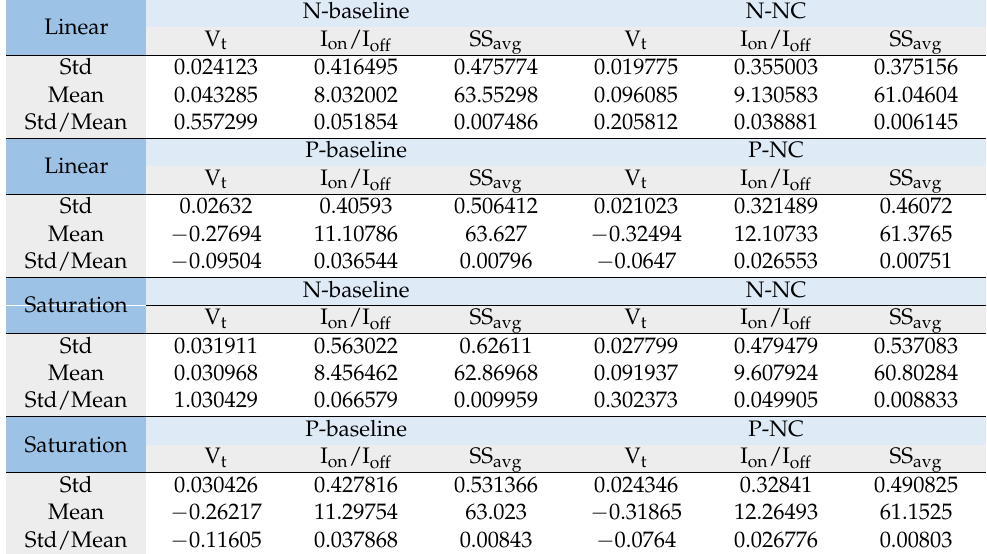
Figure 5. Simulated I DS -V GS curves ( a ) for n-type JL-NWFET (JL) and ( b ) for n-type NC-JL-NWFET (NC-JL) with LER. I DS -V GS curves ( c ) for p-type JL-NWFET (JL) and for ( d ) p-type NC-JL-NWFET (NC-JL) with LER. The dotted line indicates the nominal I DS -V GS for JL-NWFET and NC-JL-NWFET. Table 4. Variation parameters of n-/p-type JL-NWFET and NC-JL-NWFET in linear and saturation mode with line edge roughness.